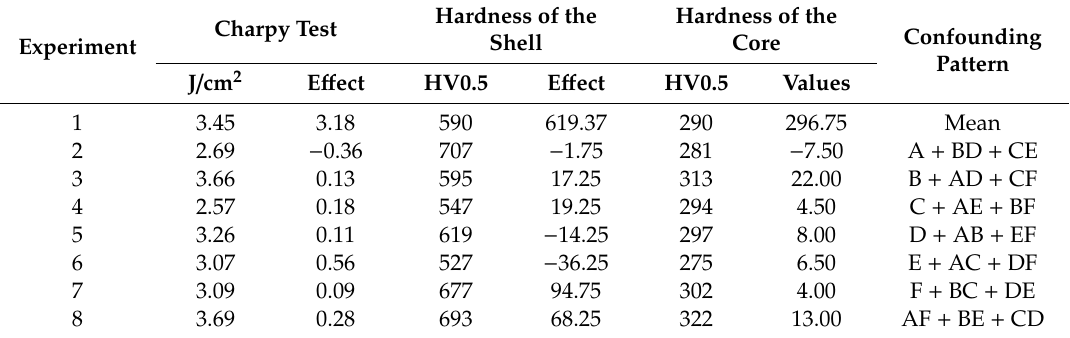
Table 6. Mean values and standardized e ff ects. HV0.5 (Vickers hardness with a load of 0.5 kg). Hardness of the Charpy Test Experiment